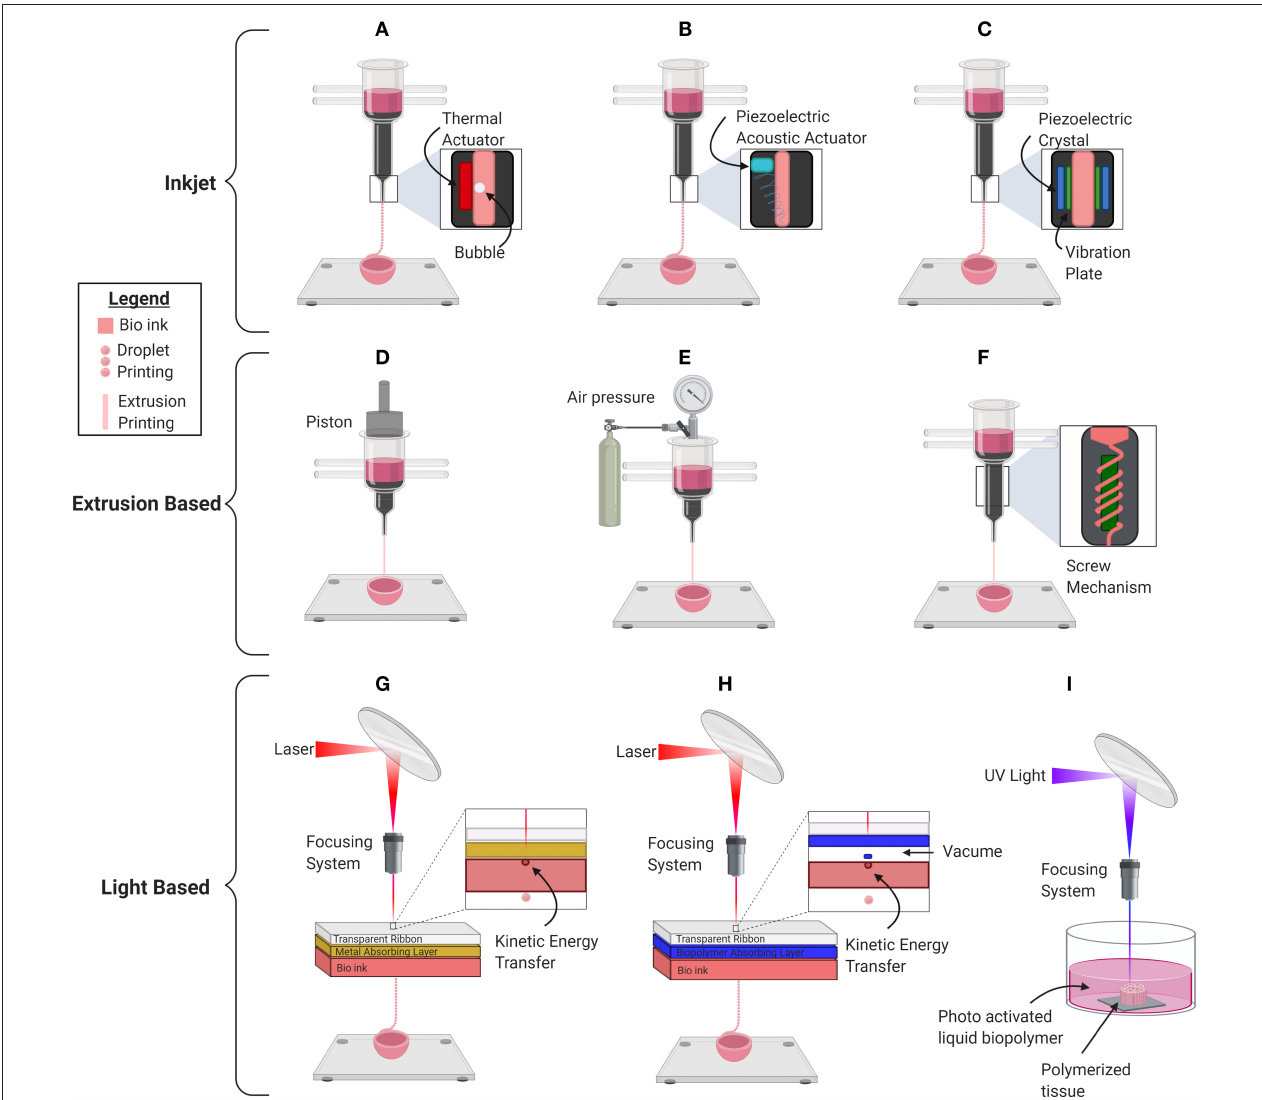
FIGURE 3 | Schematic depiction of the basic mechanical inner workings of the current commercially used major bioprinting technologies for printing organs, organoids, and other biological material. (A) Thermal inkjet printer. (B) Piezoelectric mechanical inkjet printer. (C) Piezoelectric acoustic inkjet printer. (D)